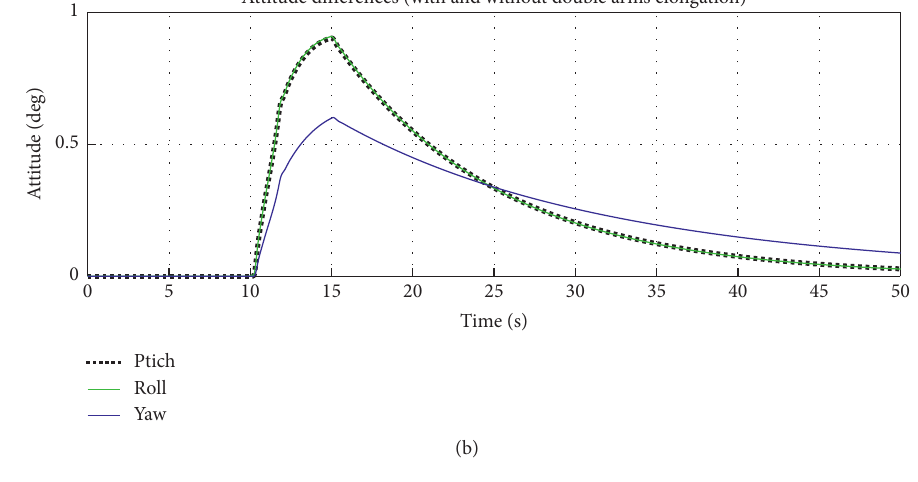
Figure 7: Curve of double-arm elongation.